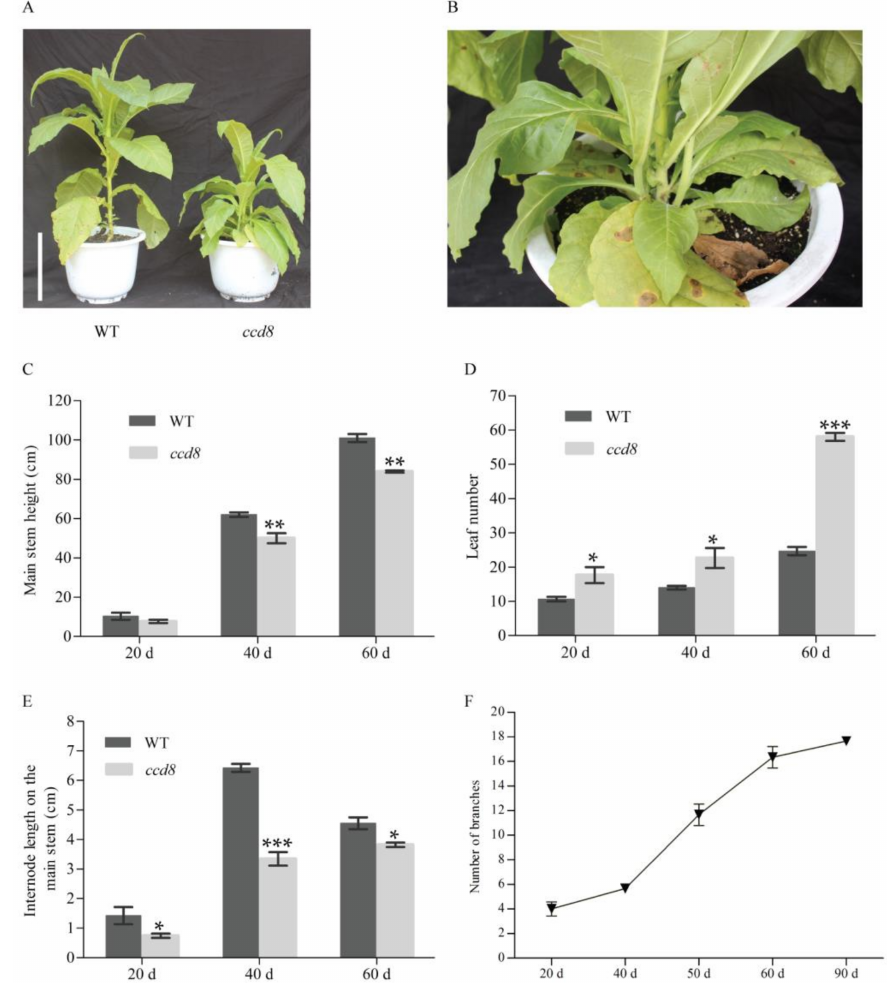
Figure 4. Shoot phenotype in ntccd8 mutant and wild-type plants. ( A ) Photograph of 40-day-old wild-type and ntccd8 mutant plants. The scale bars equal to 20 cm. ( B ) Detail of primary branches in 40-day-old ntccd8 mutant plants. Main stem length ( C ), leaf number ( D ) and internode length of the main stem ( E ) were determined at 20 d, 40 d and 60 d after transplanting, respectively. ( F ) Total number shoot branches in ntccd8 mutant plants at 20 d, 40 d, 50 d, 60 d and 90 d after transplanting. Data are represented as the means ± SD ( n = 10 for wild-type plants versus n = 12 for mutant plants). The asterisks indicate statistically significant differences compared to wild-type plants (* p < 0.05, ** p < 0.01 and *** p < 0.001; Student’s t